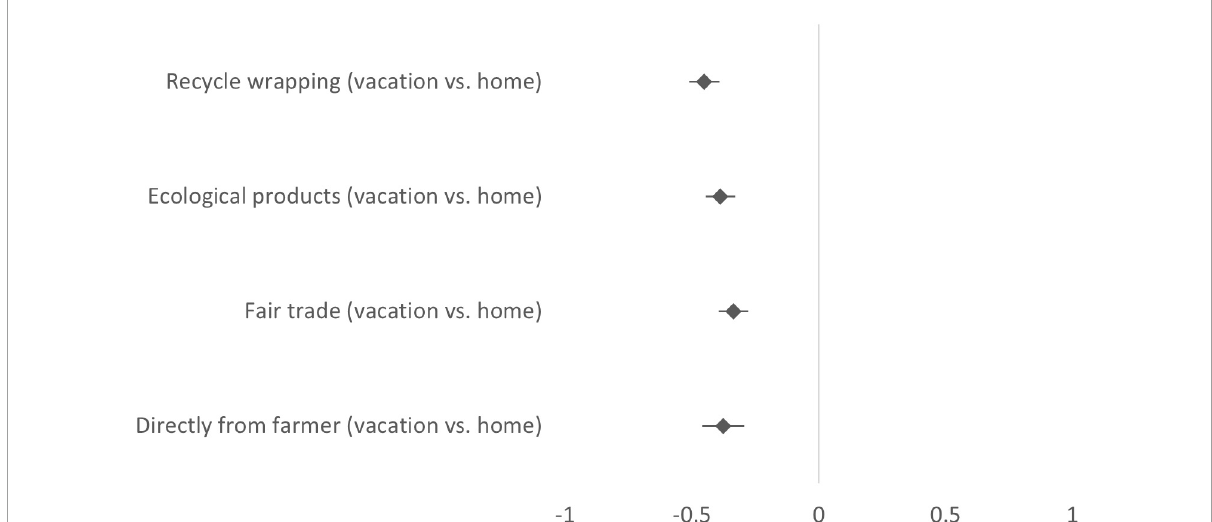
FIGURE1 Purchasing intentions when visiting a local food market, compared between contexts (answer scale: 1 = Very unlikely, 5 = Very likely). Mean differences (diamonds) are shown with 95% confidence intervals (bars). A positive value indicates that the likelihood to purchase sustainable products was rated higher in the vacation scenario than in the home scenario, a negative value indicates that it was rated lower.